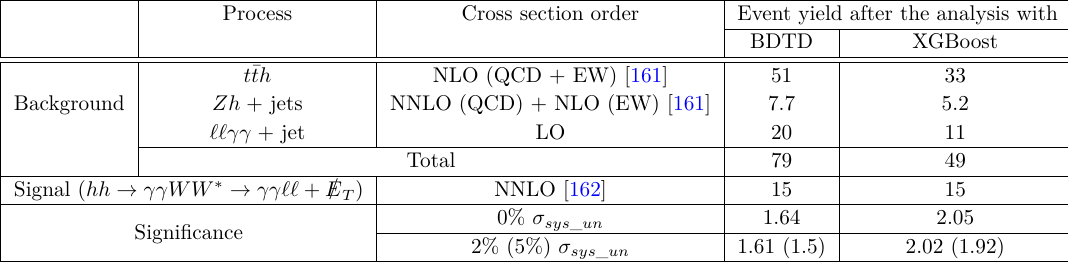
Table 6 . The signal and background yields at the HE-LHC along with the signal significance for the WW ∗ γγ channel from the analysis using BDTD and XGBoost